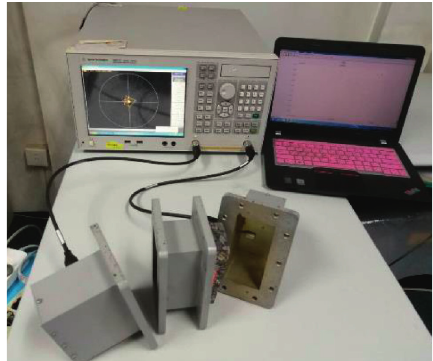
Figure 3: Dielectric constant measurement of the asphalt mixture test